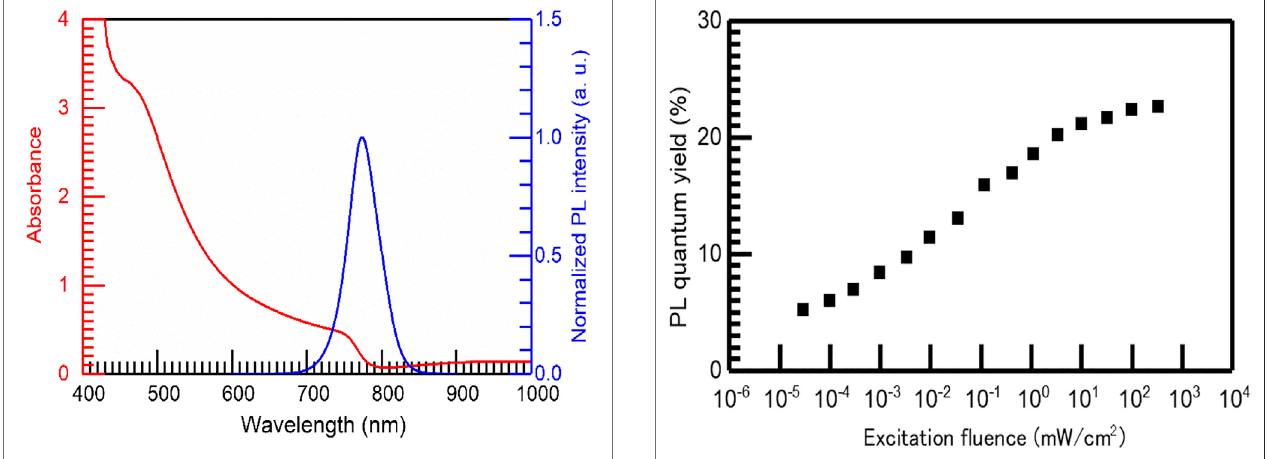
FIGURE 4 | Plot of PL quantum yields as a function of excitation fl uence for MA